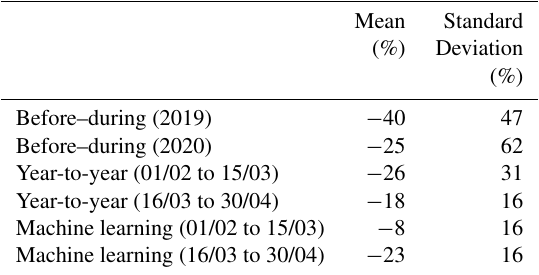
Table 2. Scores over all European urban areas included in the dataset for the different TROPOMI NO 2 tropospheric-column- change estimates. Mean and standard deviation are calculated for the median estimates of all urban areas considered in the study; i.e. the standard deviation is a metric of the inter-urban-area spread. Dates are in